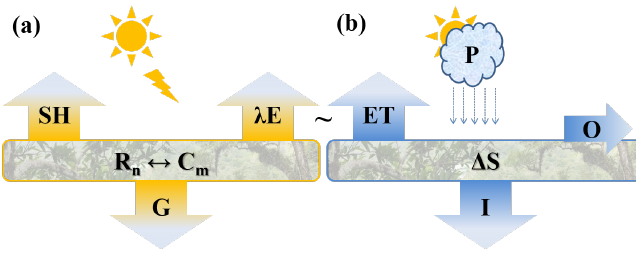
Figure 2. ( a ) Energy balance and ( b ) water balance (reprinted from Song